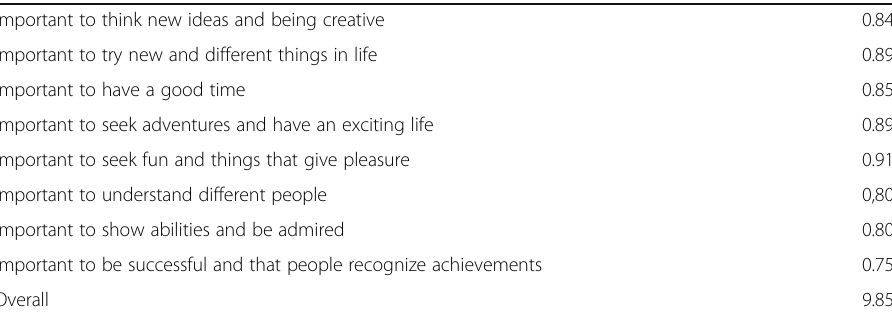
Table 5 KMO test for conservatism/embeddedness vs